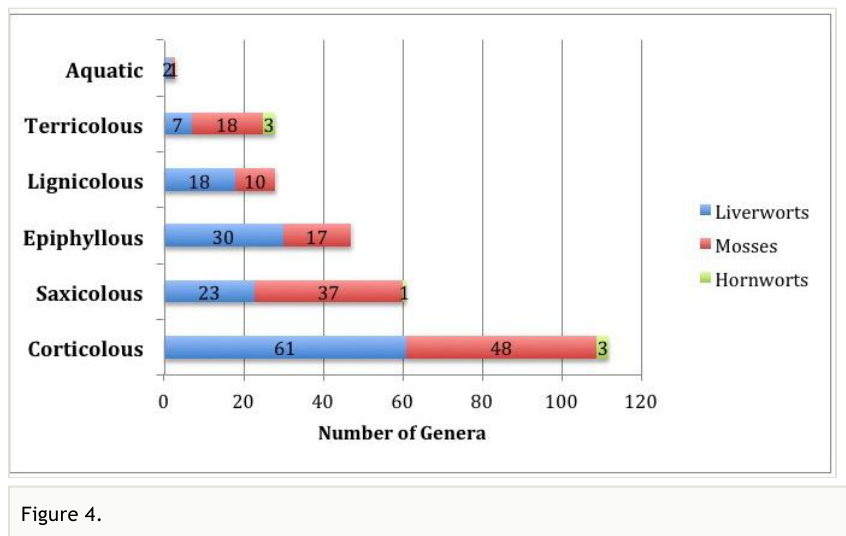
Figure 4. Distribution of bryophytes on six